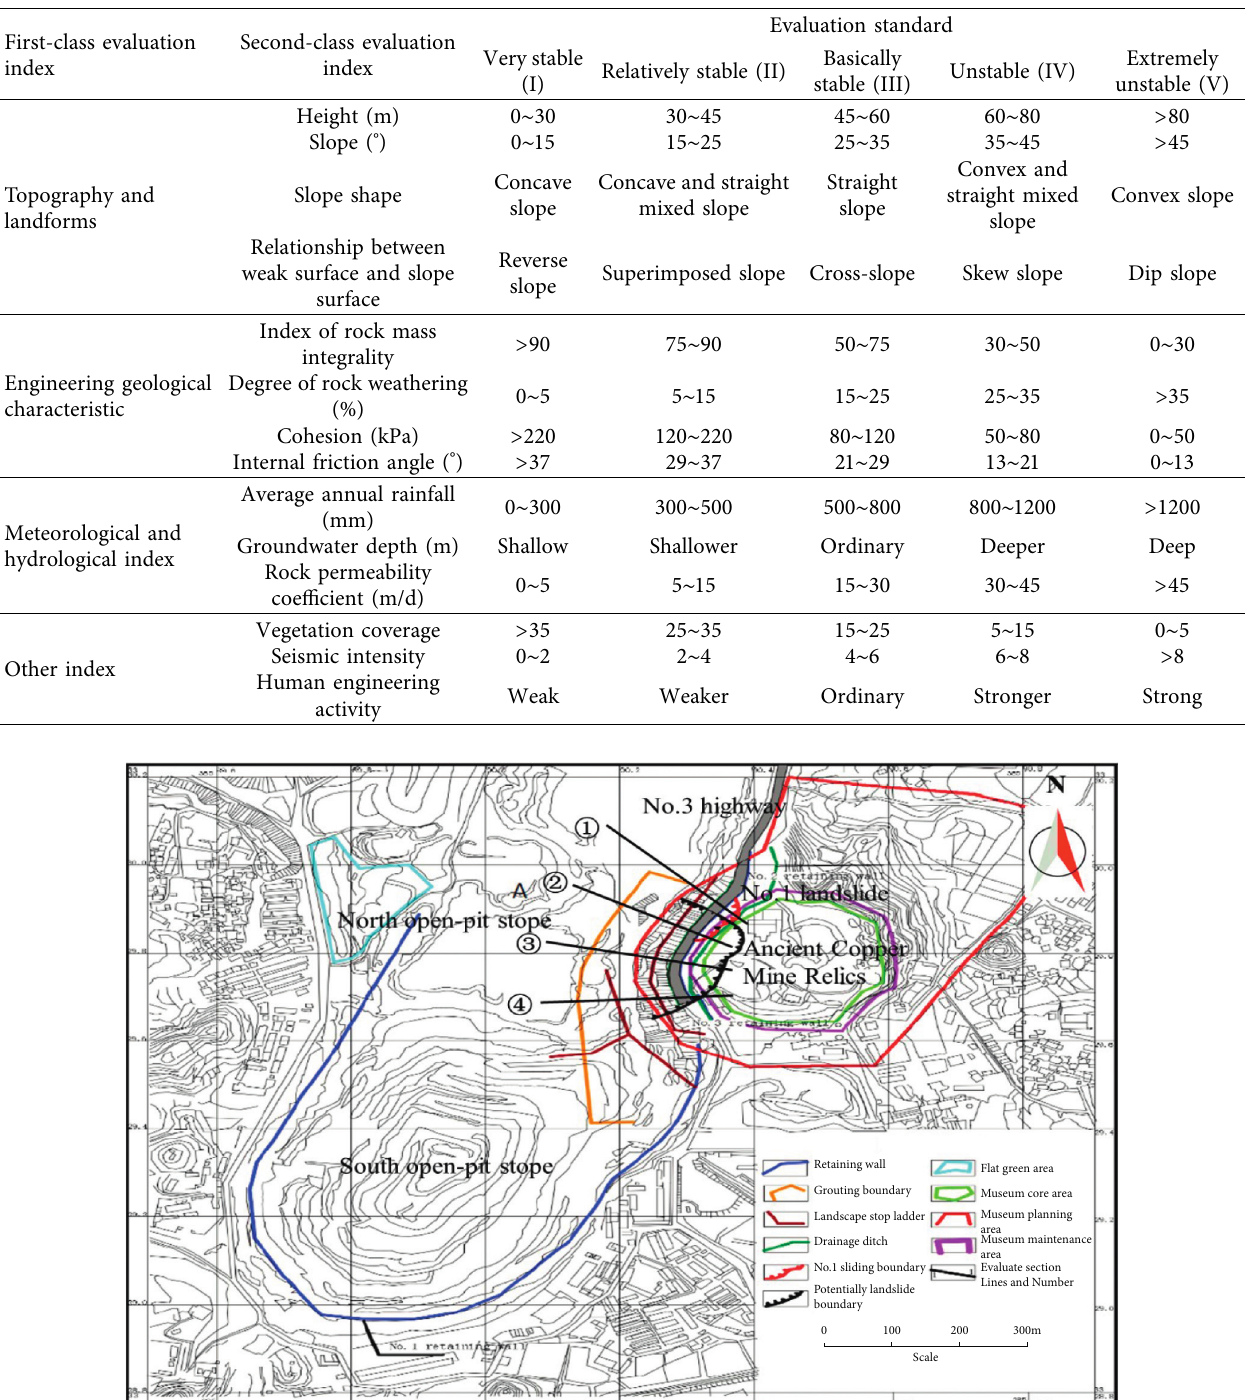
Table 2: Comprehensive evaluation index system and evaluation standard of slope stability in open-pit mine.